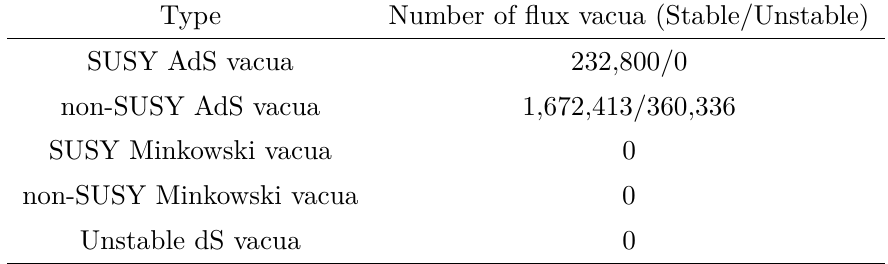
Table 1 . The number of vacua in the isotropic case.